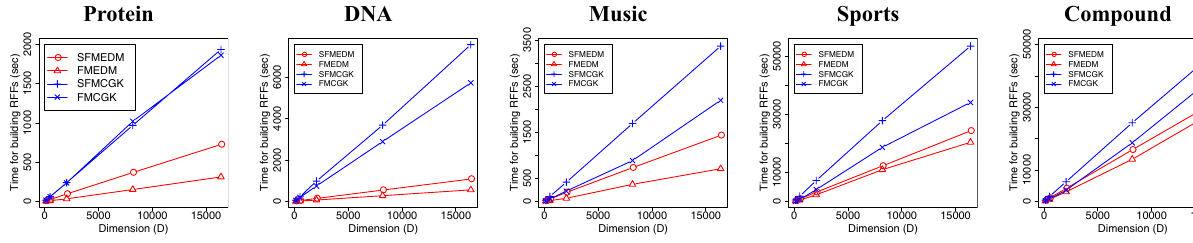
Fig. 3 Time in seconds for building vectors of RFFs for various dimensions D